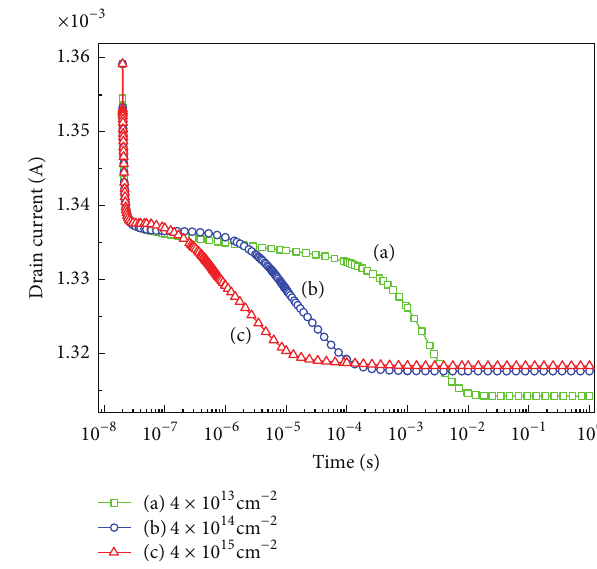
Figure 6: Drain current collapses at different energy levels. Inset is the curves of decay time to steady states. Figure 7: Drain current collapse at different trap